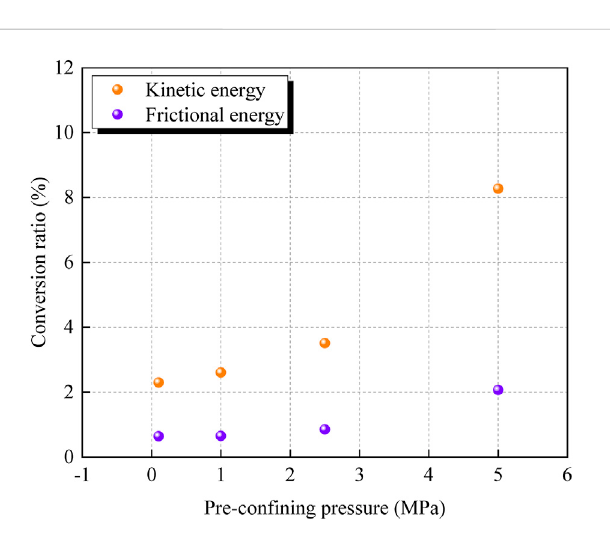
FIGURE 15 Energy conversion ratio during coalbursts under different pre- con fi ning